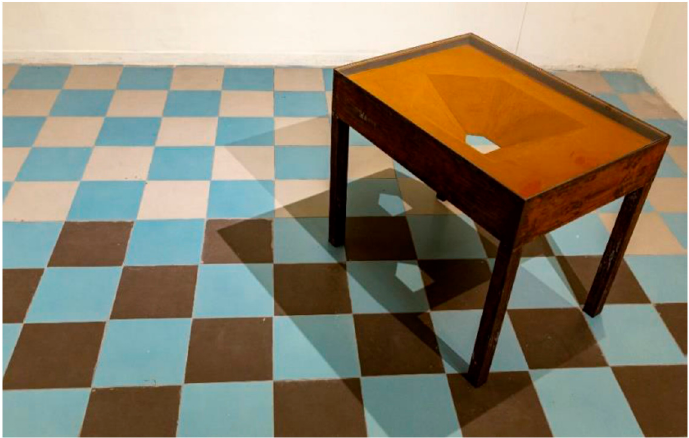
Figure 2. Micha Ullman, Sand Table , 2019. Iron and red sand, glass, 90 cm × 110 cm × 75 cm. Photograph: Micha Ullman.